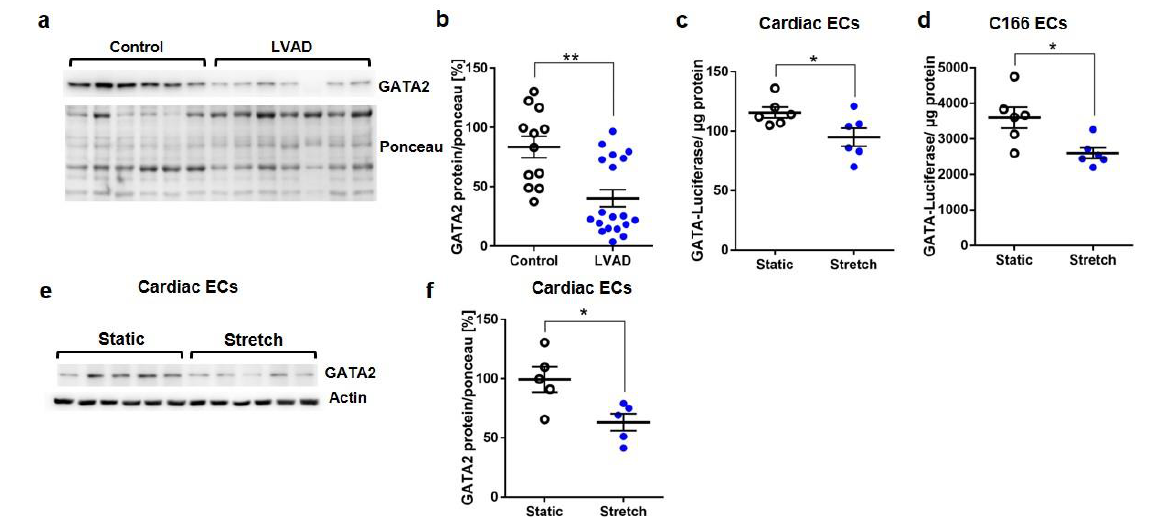
Figure 1. GATA2 is downregulated in endothelial cells upon mechanical stress. ( a ) Representative immunoblots and quantification for ( b ) GATA2 from control (healthy) and failing hearts of patients undergoing left ventricular assist device (LVAD) implantation. Ponceau staining was the loading control. Luciferase assay from primary cardiac endothelial cells (and c ) C166 endothelial cells (ECs) ( d ) infected with Ad.GATA-Luc and subjected to mechanical stretch or not (static) for 24 h. ( e ) Immunoblot for GATA2 and quantification of ( f ) primary cardiac ECs treated for 24 h, as indicated. Data are mean ± sem; the number of biological replicates is shown in bars; * p < 0.05, *** p < 0.001.